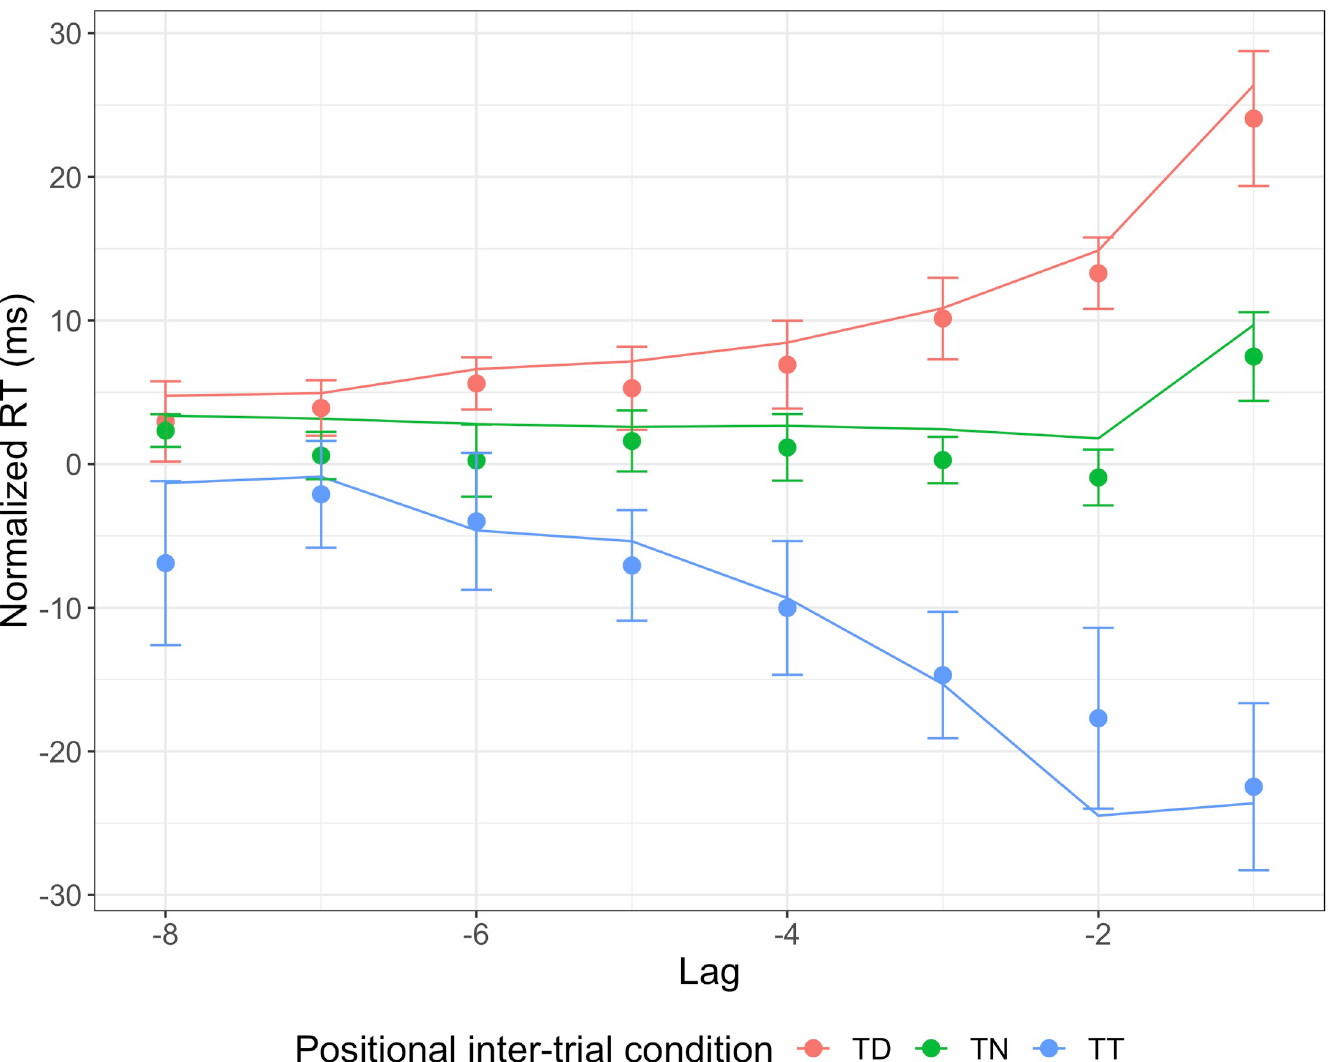
Fig 11. Temporal profile of the position based inter-trial effects. Mean normalized RT for different positional inter-trial conditions, target in previous target condition (TT), target in previous distractor position (TD), target in previously neutral (unoccupied) position (TN), compared to trial n-1 (lag 1), n-2 (lag 2) up to n-8 (lag 8). Normalized RTs were first averaged across the two sessions for each participant; the resulting (individual mean normalized) RTs were then used to compute the overall means and confidence intervals, across participants. Filled circles show the behavioral data, while lines show model predictions. Error bars represent 95% confidence